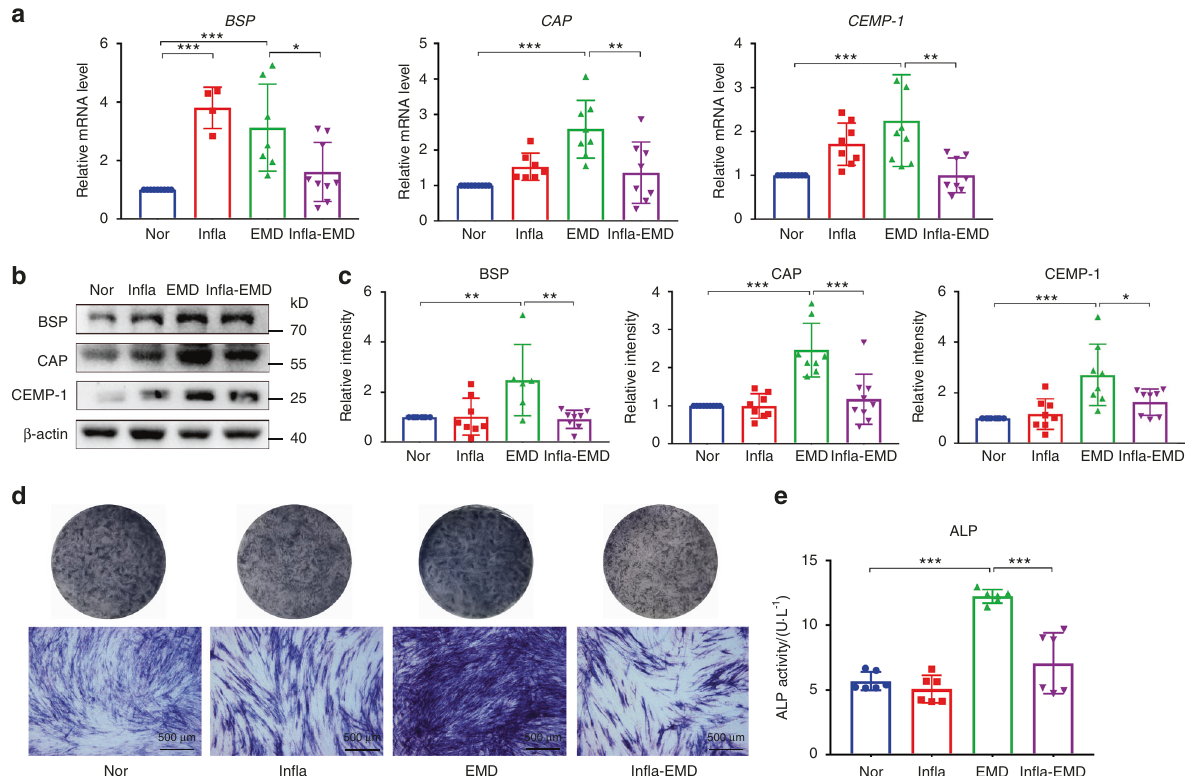
Fig. 1 In fl ammatory cytokines compromise the cementogenesis of PDLSCs. The cells were incubated in normal α -MEM (Nor), medium with the in fl ammatory cytokines TNF- α and IL-1 β (In fl a), medium with the cementoblastic inducer EMD (EMD), or medium with both in fl ammatory cytokines and EMD (In fl a-EMD). a Relative cementoblastic differentiation-related gene expression levels of BSP , CAP and CEMP-1 determined by qRT-PCR. b Relative cementoblastic differentiation-related protein expression of BSP, CAP and CEMP-1 determined by Western blots. c Semiquantitative analysis of protein expression levels (normalized to β -actin) in terms of relative gray density. d ALP staining (scale bar: 500 μ m) of PDLSCs. e Quanti fi cation of ALP activity. The data are shown as the mean ± SD for n from 4 to 9; * P < 0.05, ** P < 0.01 and *** P < 0.001 indicate signi fi cant differences between the indicated